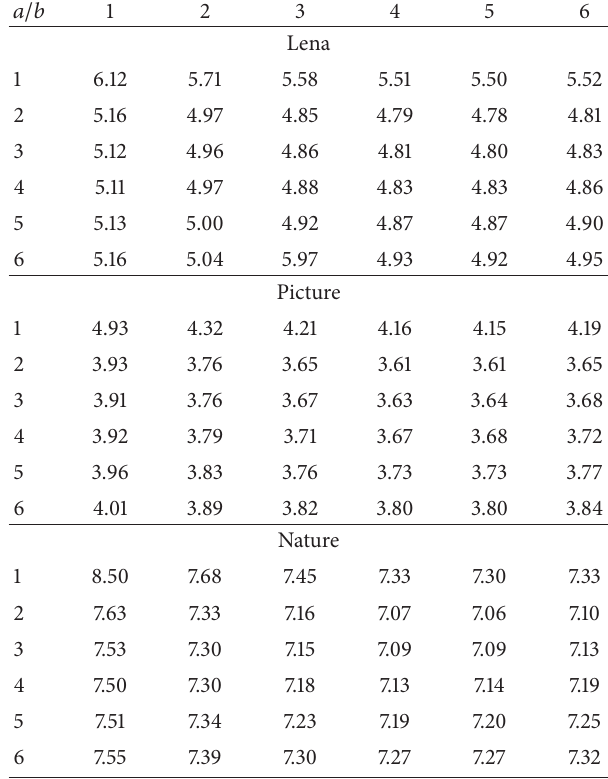
Table 1: RMSE values of the column by column basic function creation.